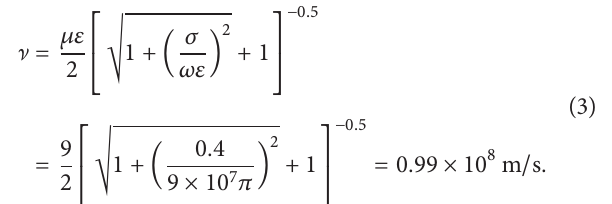
Figure 8: Reconstruction of the breast